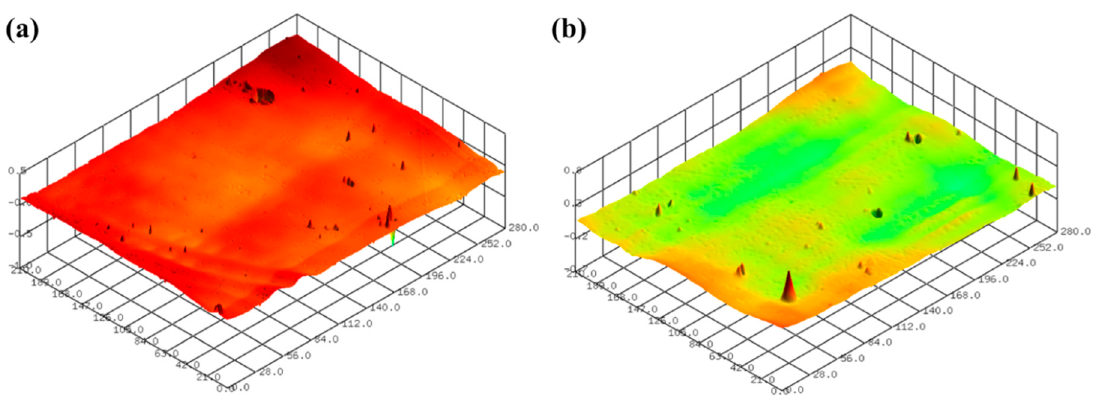
Figure 12. Representative surface profiles of SLA 3D-printed ABS-like resin after sanding and CMP for 2 min and 150 min, respectively; ( a ) Sa of 0.041 μ m and Sz of 1.281 μ m ( b ) Sa of 0.037 μ m and Sz of 1.135 μ m.